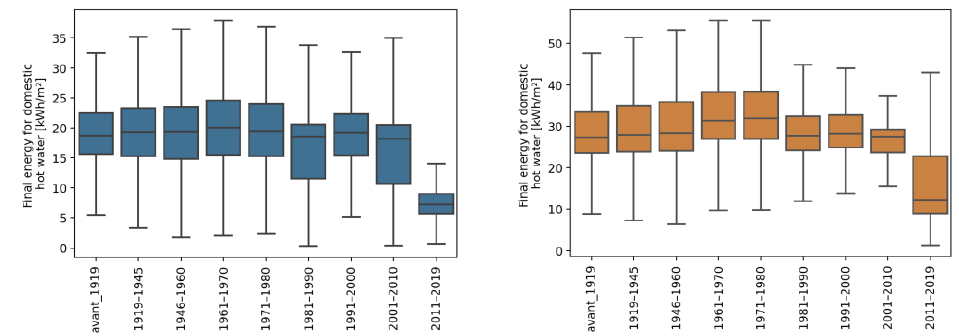
Figure 7. Spread of the final energy for domestic hot water of single-family and multi-family houses for each period of construction.